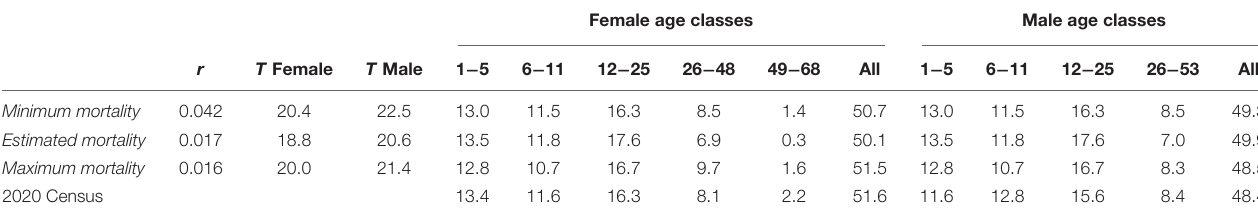
TABLE 4 | Deterministic population growth rate ( r ), mean generation time ( T ) for males and females, and stable age distribution (expressed as %), calculated from mean demographic rates. Female age classes Male age classes